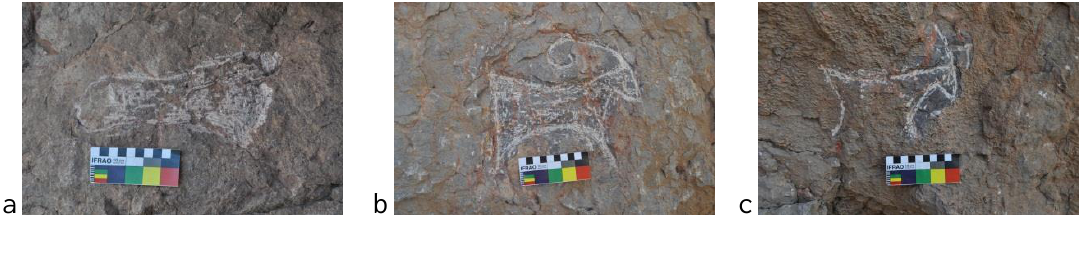
Figure 6 . Engravings consisting of depiction of a foot and ibexes at Site